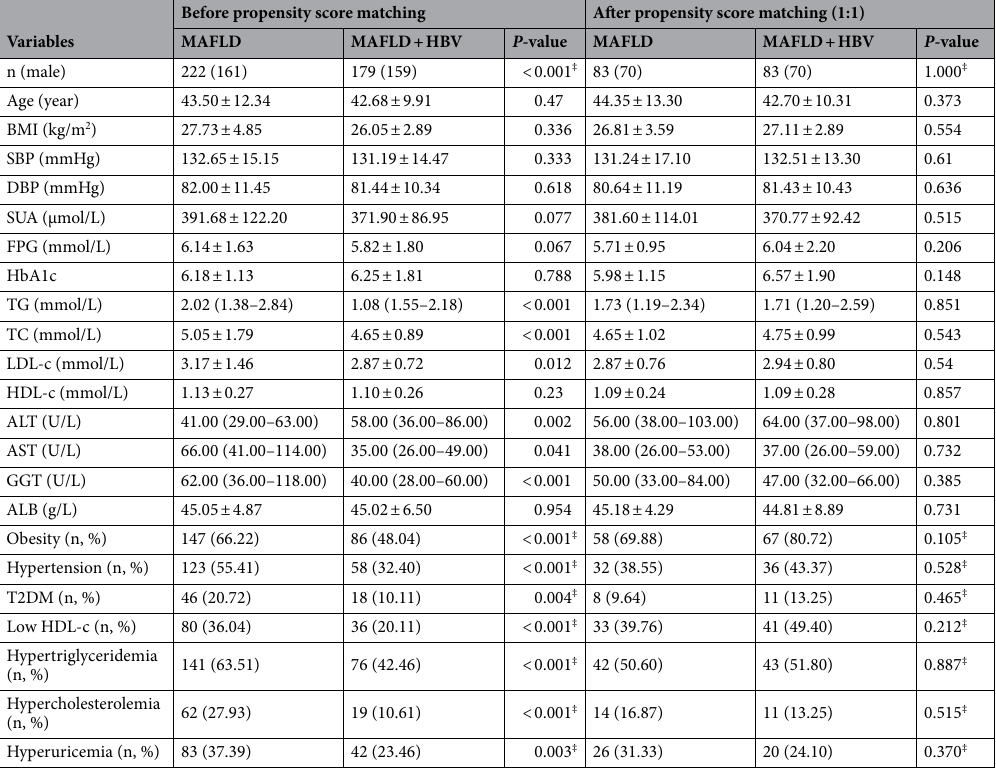
Table 1. Comparison of clinical characteristics between metabolic dysfunction-associated fatty liver disease with and without hepatitis B virus infection before and after propensity score matching. Data are expressed as mean ± standard deviation or median (interquartile range). MAFLD metabolic dysfunction-associated fatty liver disease, BMI body mass index, SBP systolic blood pressure, DBP diastolic blood pressure, SUA serum uric acid, FPG fasting plasma glucose, TG triglycerides, TC total cholesterol, LDL-c low-density lipoprotein cholesterol, HDL-c high-density lipoprotein cholesterol, ALT alanine aminotransferase, AST aspartate aminotransferase, GGT gamma-glutamyl-transferase, T2DM type 2 diabetes mellitus. ‡ P -value calculated